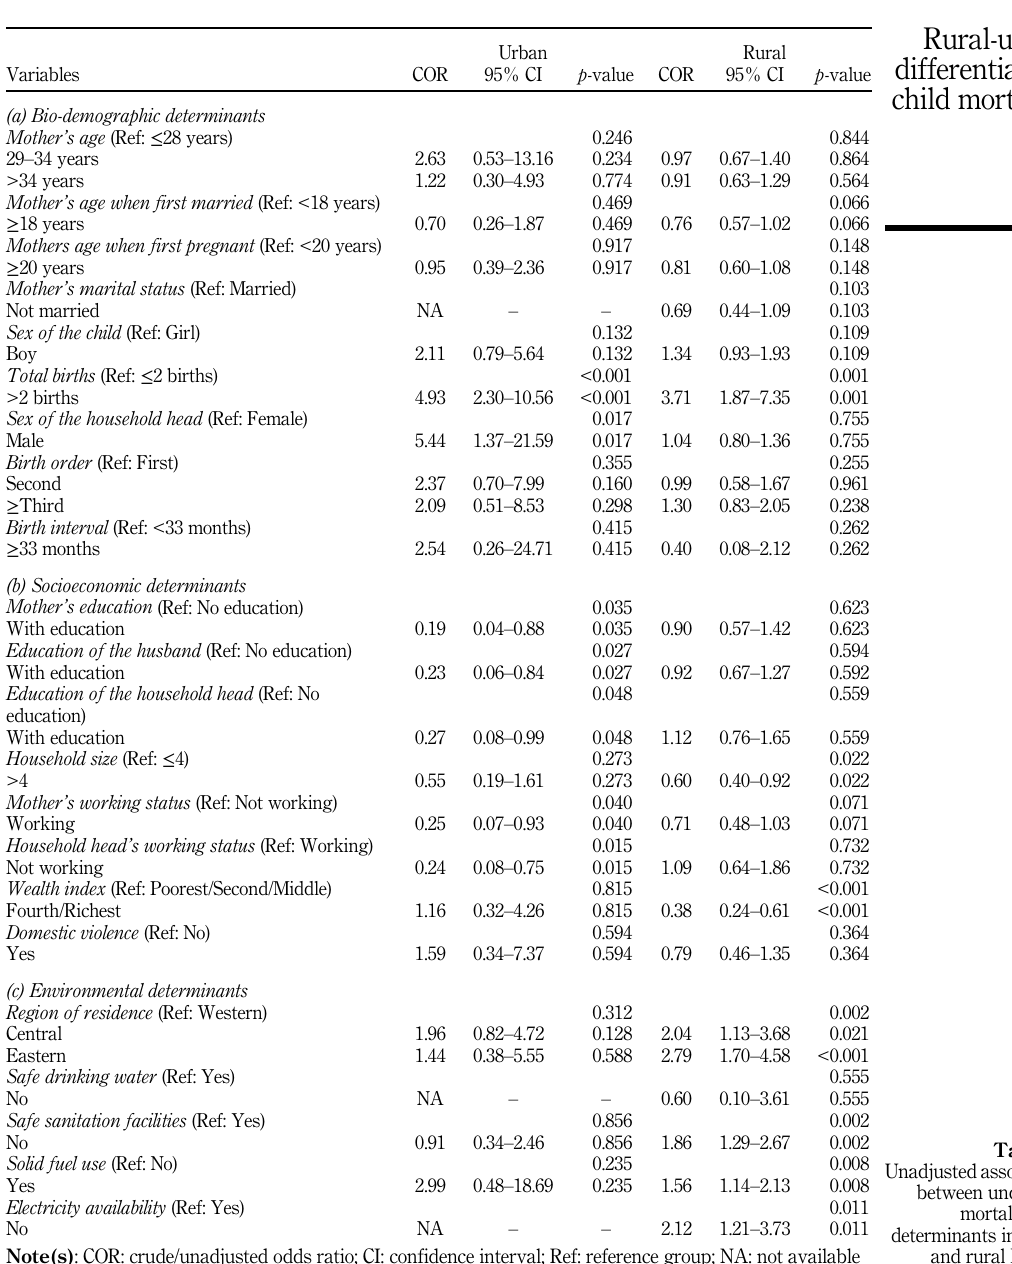
Table 2. Unadjusted association between under-five mortality and determinants in urban and rural